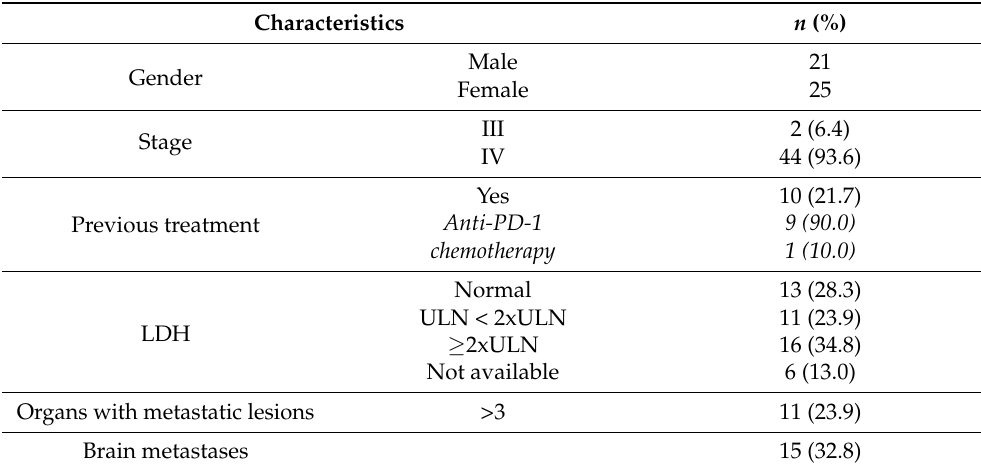
Table 1. Study population